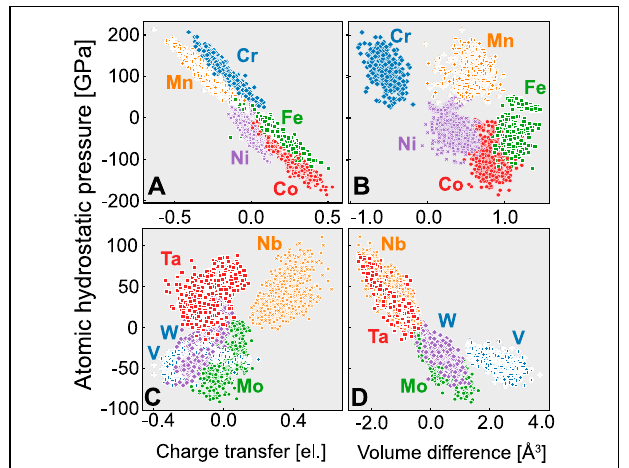
FIGURE 4 | Relationship between atomic hydrostatic pressure and the atomic quantities of charge transfer and volume difference, for (A,B) fcc random alloys and (C,D) bcc random alloys.